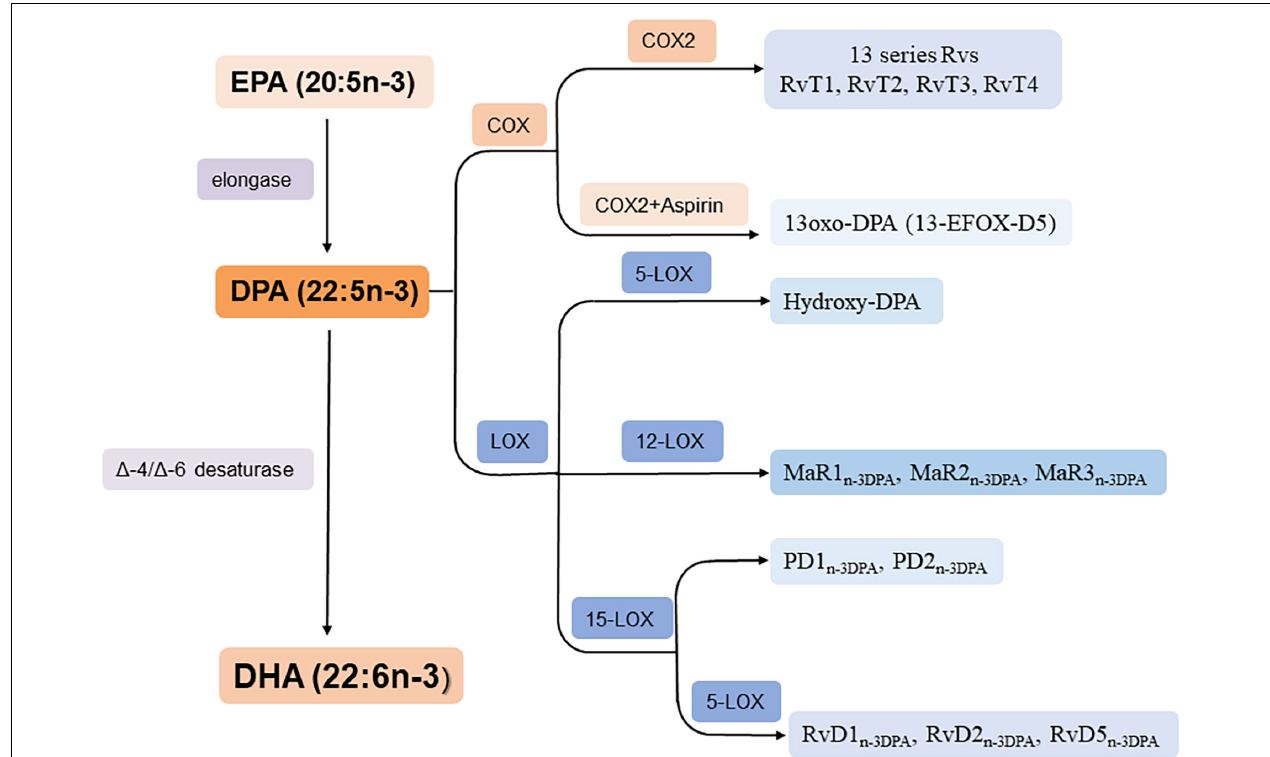
FIGURE 2 | Biosynthesis of n-3 DPA-derived bioactive lipids. RvT1: 7,13R, 20-tri hydroxy-n-3 DPA; RvT2: 7,12,13R-tri hydroxy-n-3 DPA; RvT3: 7,8,13R-trihydroxy-n-3 DPA; RvT4: 7,13R-dihydroxy-n-3 DPA.